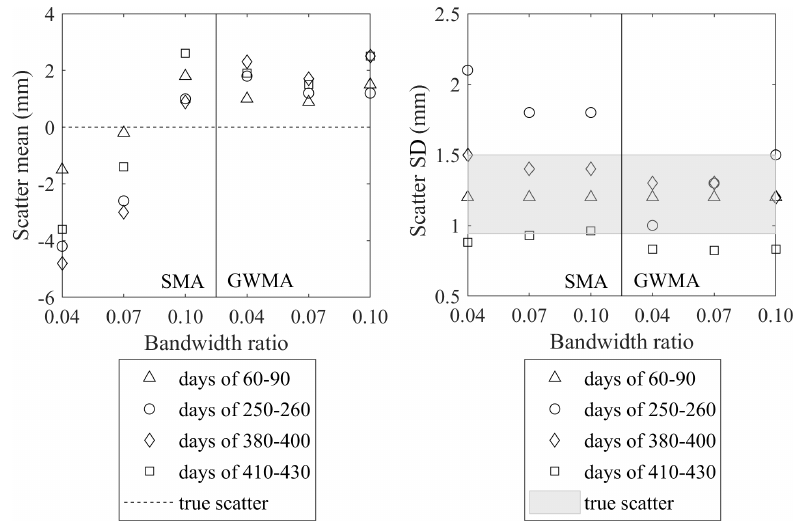
Figure 19. Mean and standard deviation of scatter inferred by SMA and GWMA in comparison with true scatter in the displacement of Geocube